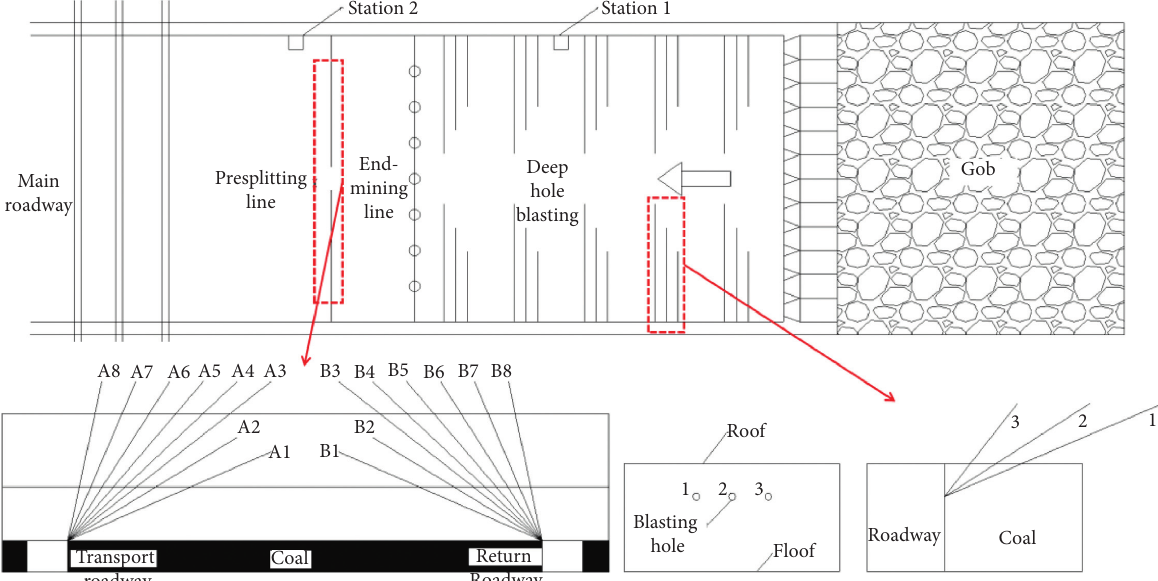
Figure 14: Blasting plan and blast hole